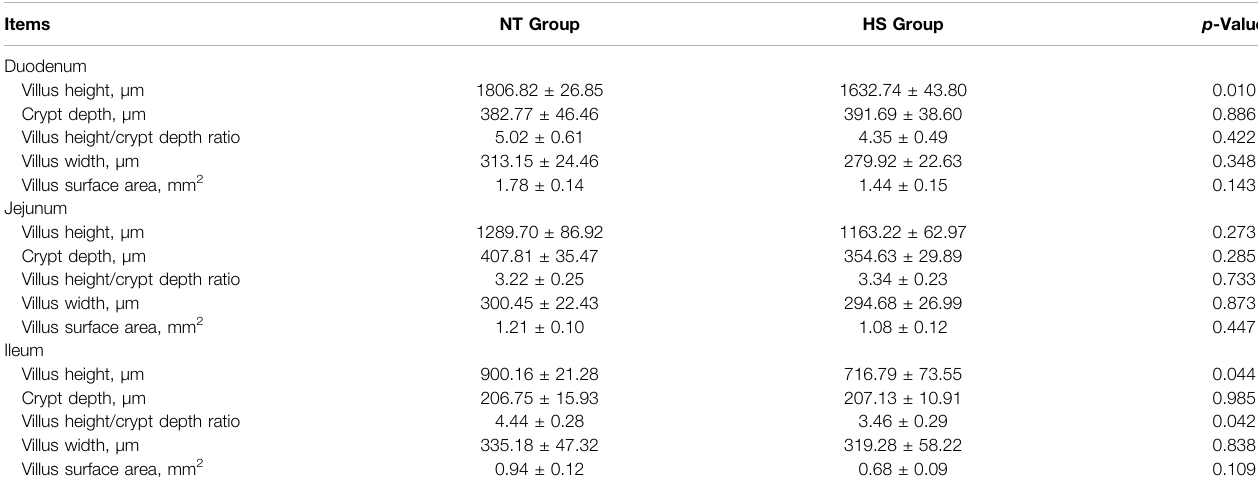
TABLE 4 | Effects of heat stress on intestinal morphology in indigenous broilers.